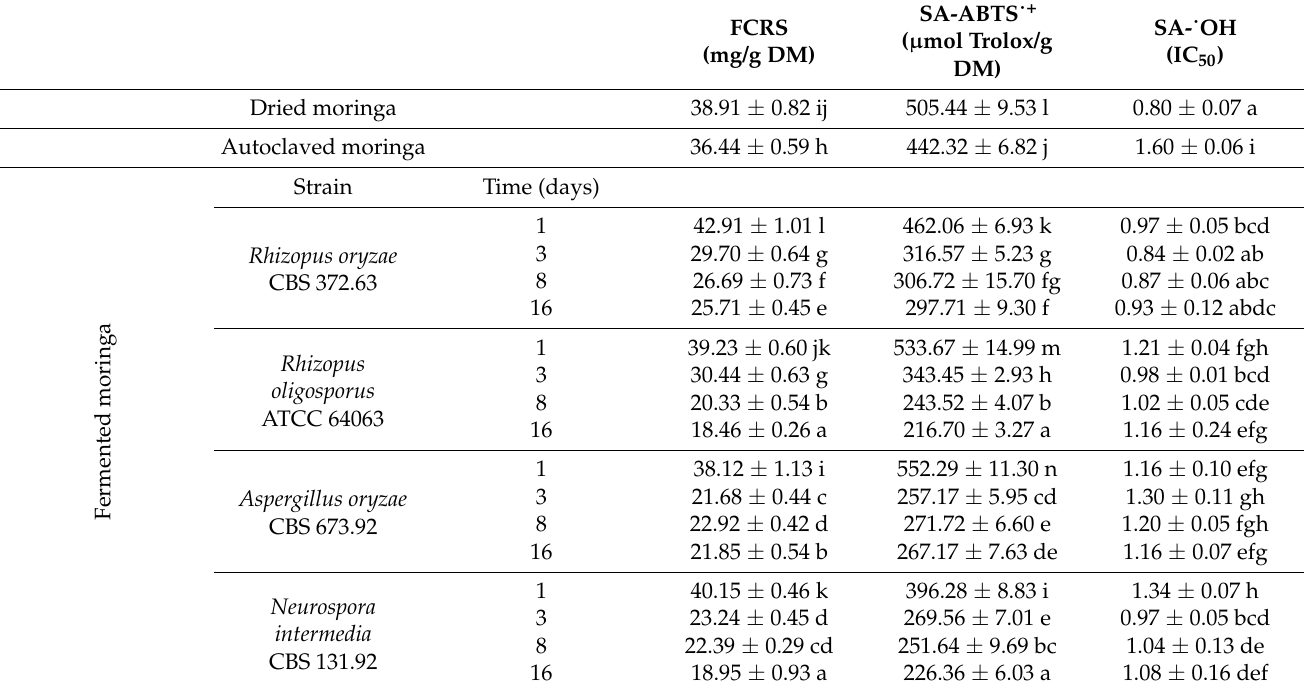
Table 1. The antioxidant potential of moringa leaves—dried, autoclaved, and fermented with the studied